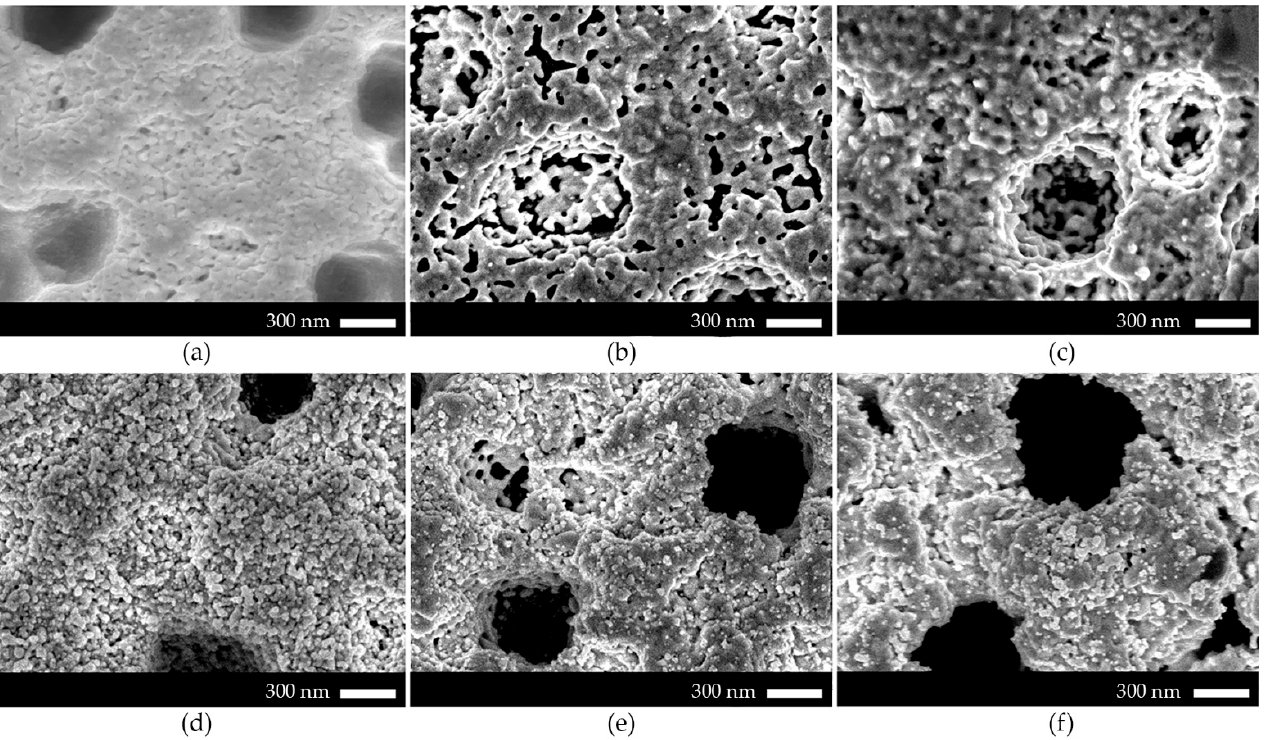
Figure 6. SEM images for the macro-PS after 30 min ( a ), 40 min ( b ), 50 min ( c ), 60 min ( d ), 70 min ( e ), and 80 min ( f ) of Au deposition.